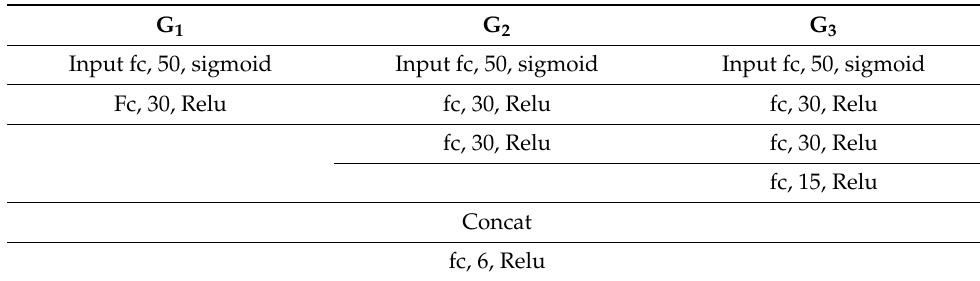
Table 1. Global network parameters of the